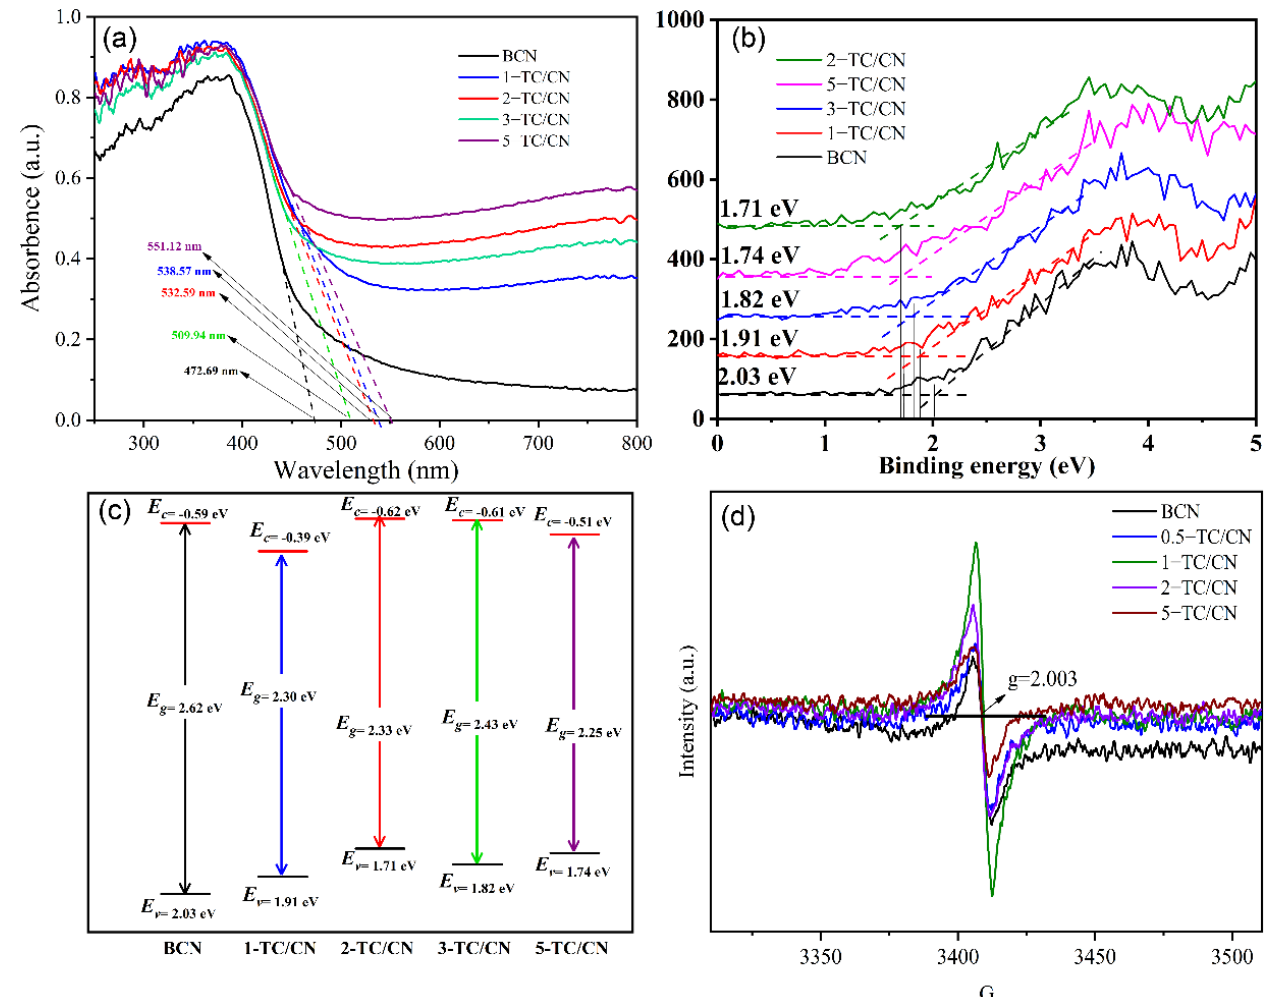
Figure 4. Diffuse reflectance spectra of g − C 3 N 4 ( a ), XPS valence − band spectra ( b ), band structure ( c ) and electron paramagnetic resonance (EPR) spectra ( d ), of g − C 3 N 4 and (1–5) − TC/CN.